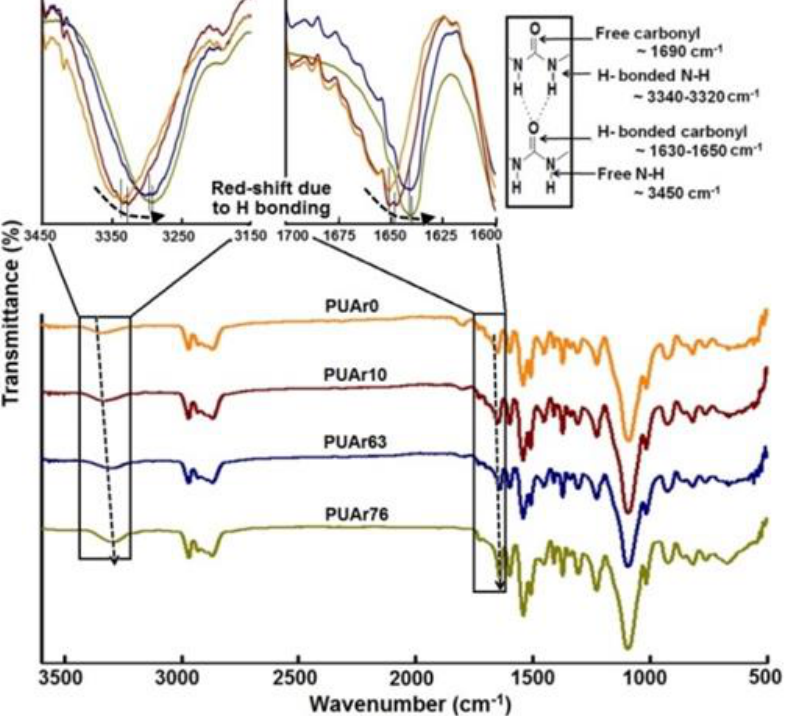
Figure 2. FTIR spectra of the red-shift associated with NH and C = O bands. Reproduced with permission from ref. [50].